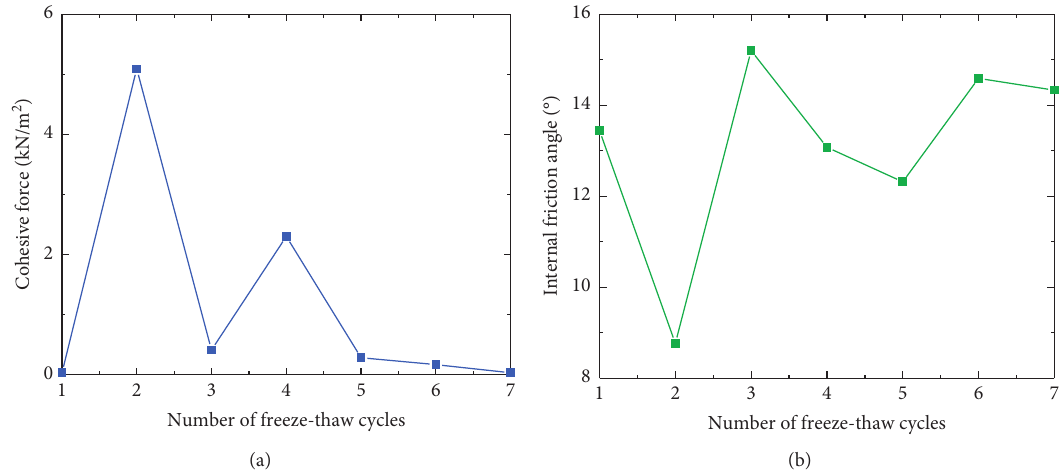
Figure 14: Relationship between shear strength parameter and number of freezing-thawing cycles: (a) cohesive force and (b) internal friction angle.